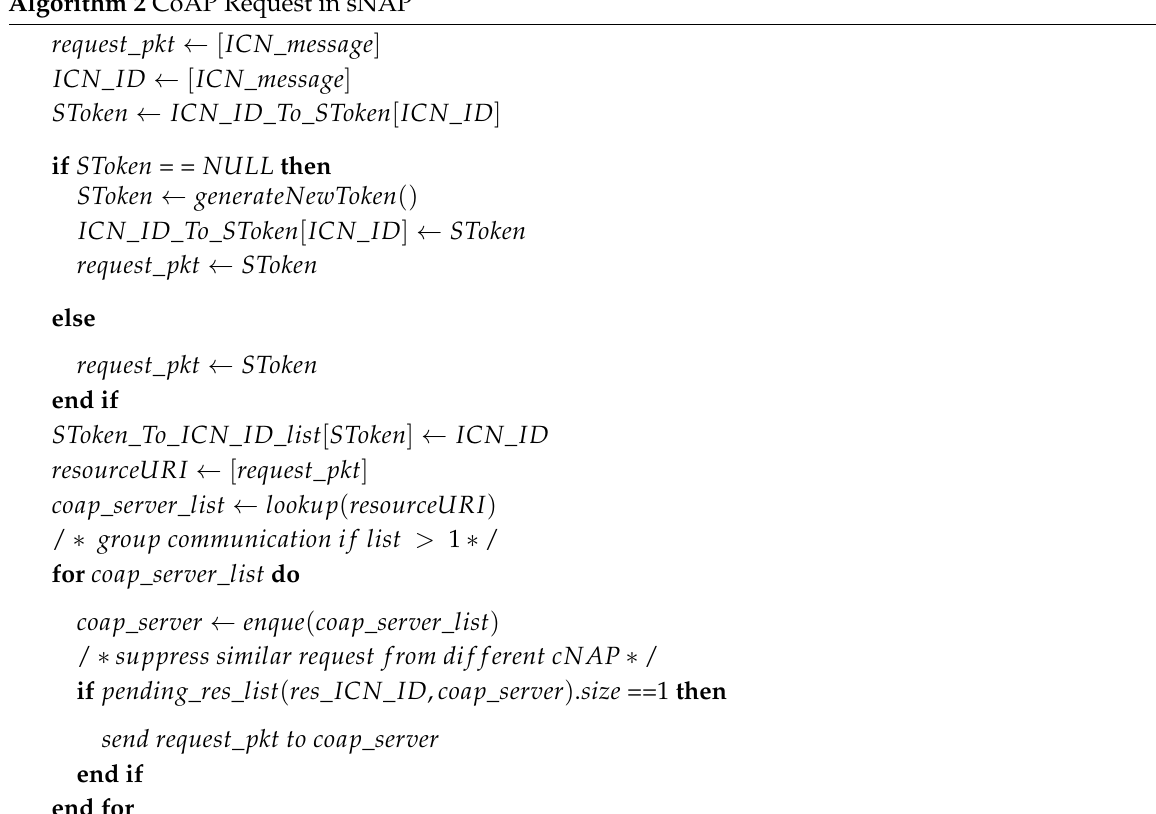
Algorithm 2 CoAP Request in